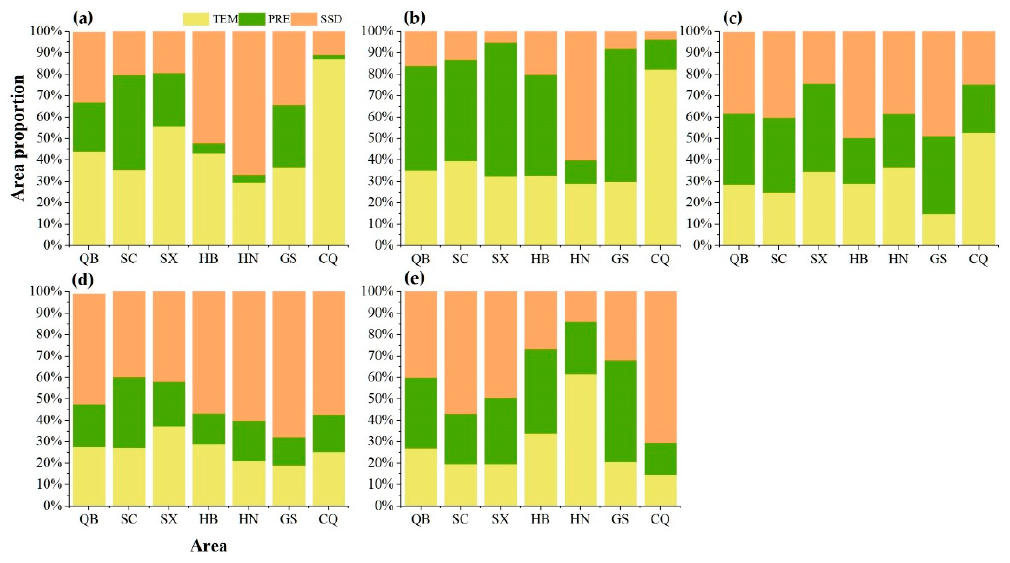
Figure 17. Proportion of the main control area of climate factors in the QBM. ( a ) Year; ( b ) Spring; ( c ) Summer; ( d ) Autumn; ( e ) Winter.